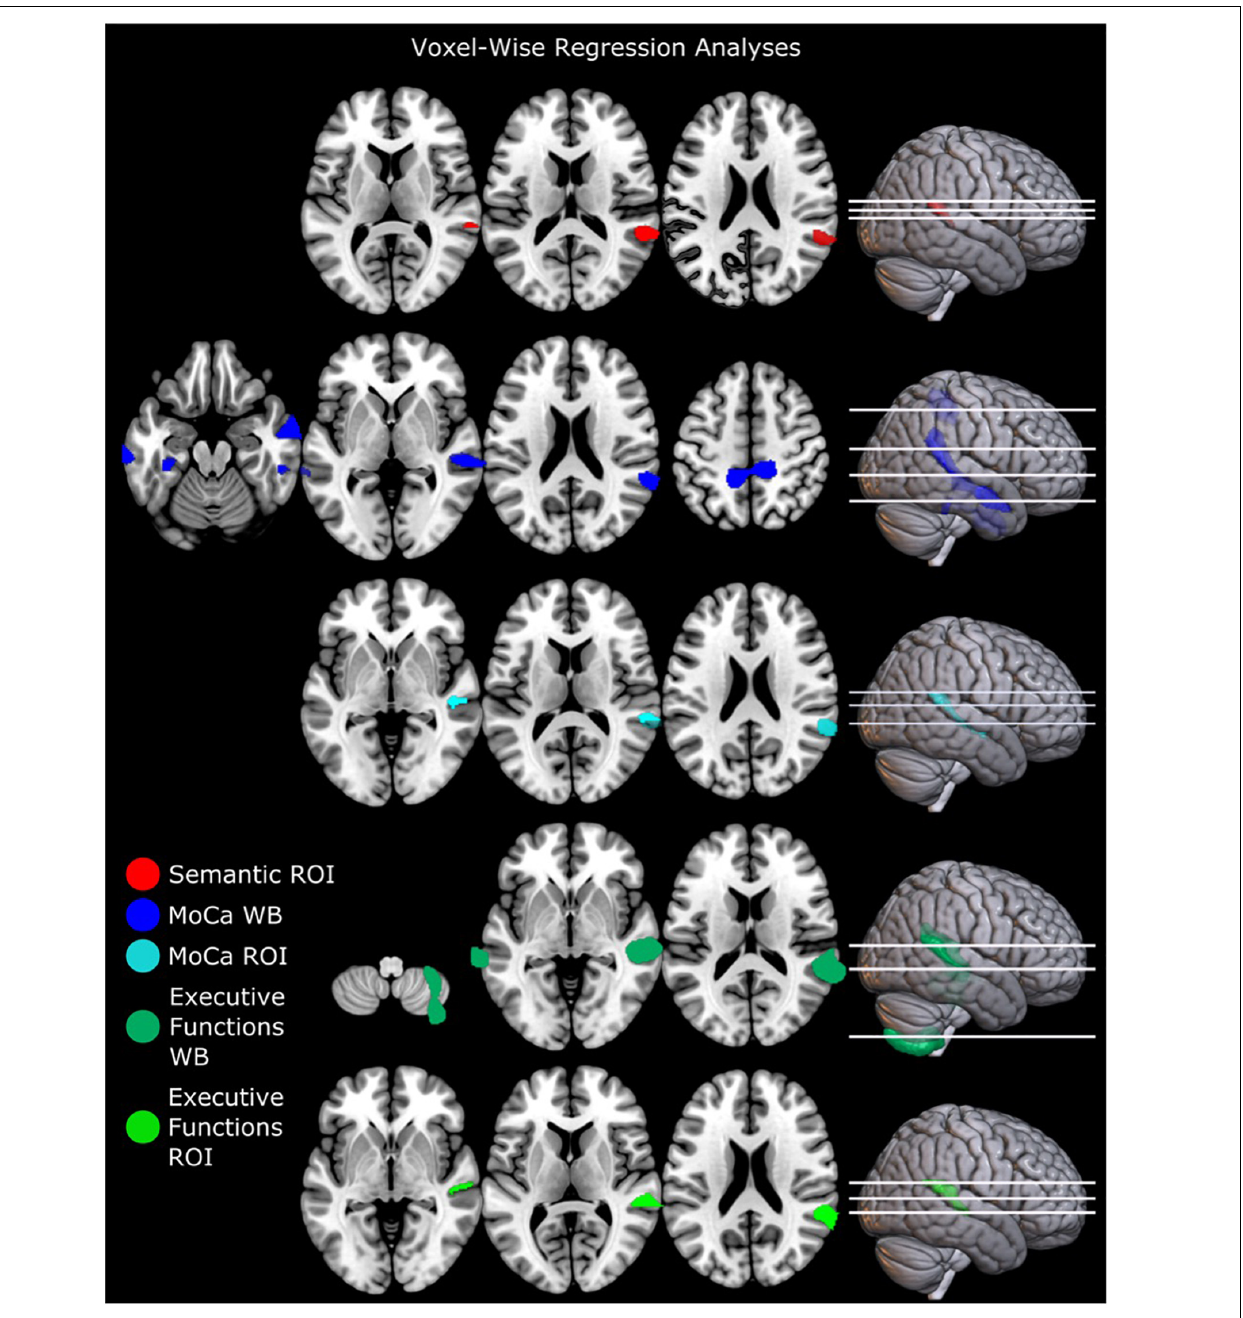
FIGURE 1 | Regression analyses of brain structure and cognitive and linguistic factors in PD with mild and moderate dysarthria. Executive functions were calculated as a composite score (see Supplementary Material ). Results are corrected for multiple comparisons with FWEc p < 0.05. ROI mask comparisons were only significant in the right hemisphere. Left is displayed left. Abbreviations: totDPD, PD with mild and moderate dysarthria; MoCA, Montreal Cognitive assessment; ROI, region of interest; Semantic, verbal fluency semantic score; WB, whole-brain